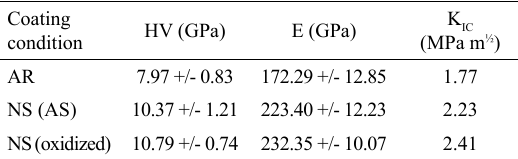
C -25(Ni20Cr) 3 2